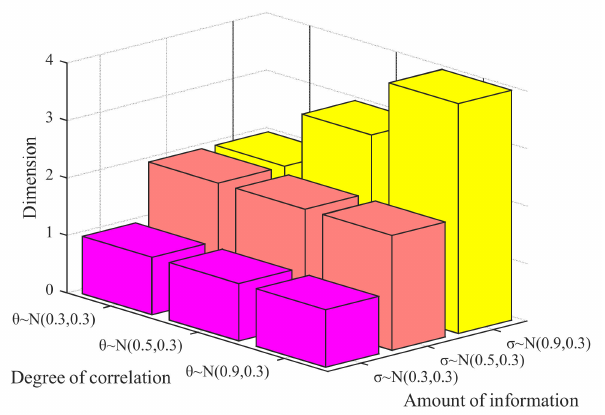
Figure 25. Relationship among degree of correlation, amount of information and dimension.